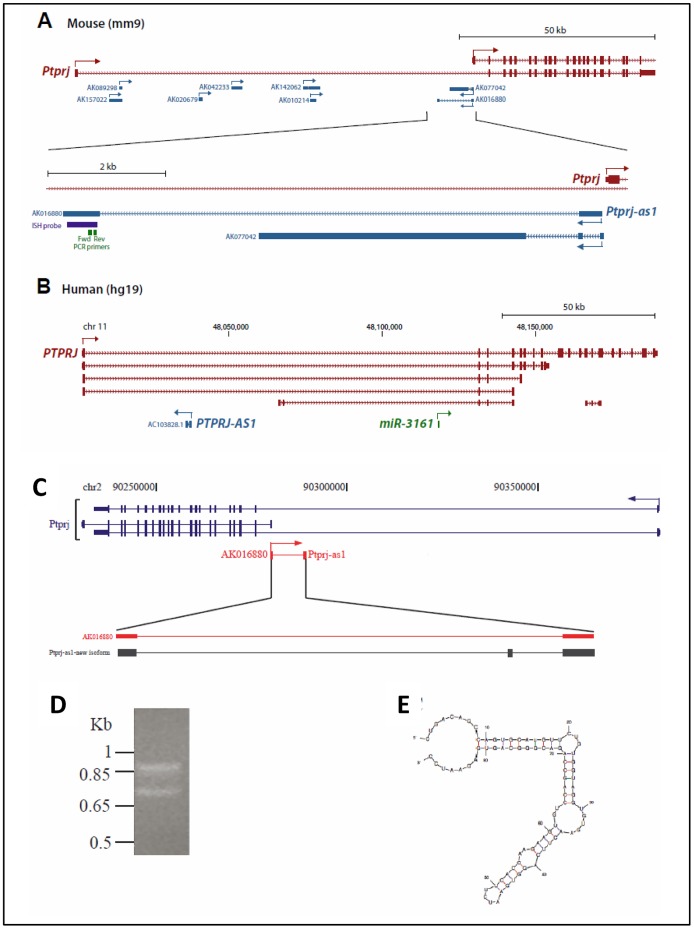
Characterisation of Ptprj-as1.
A–B: Ptprj-as1 maps to the reverse strand within the boundaries of the murine Ptprj gene. Comparison of the mouse Ptprj (A) and human PTPRJ (B) loci. Protein coding transcript isoforms of Ptprj/PTPRJ are shown in red and long noncoding transcripts are shown in blue. Arrows indicate the direction of transcription. The human microRNA miR-3161 is shown in green. Position of PCR primers used for qRT-PCR for mouse Ptprj-as1 are indicated. C-D: Mapping (C) and expression (D) of a splice variant of murine Ptprj-as1 in brain, kidney and testis. E: Predicted secondary structure of Ptprj-as1 splice variant.